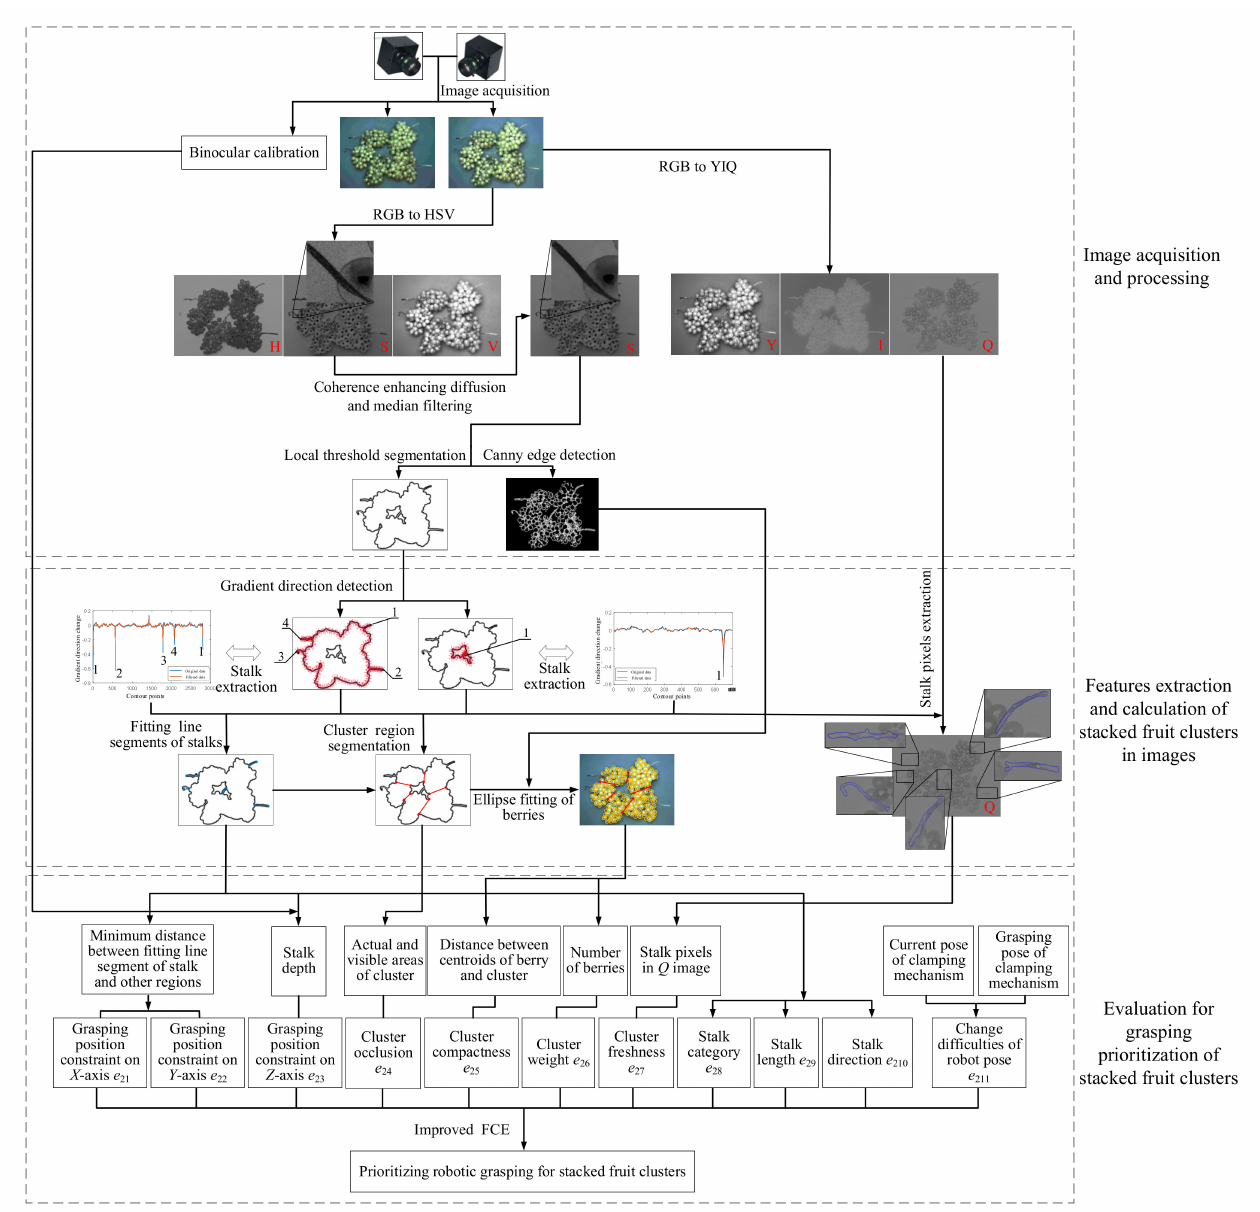
Figure 3. Prioritizing robotic grasping for stacked fruit clusters based on improved FCE. e ij represents the j th factor of the i th layer in the hierarchical tree